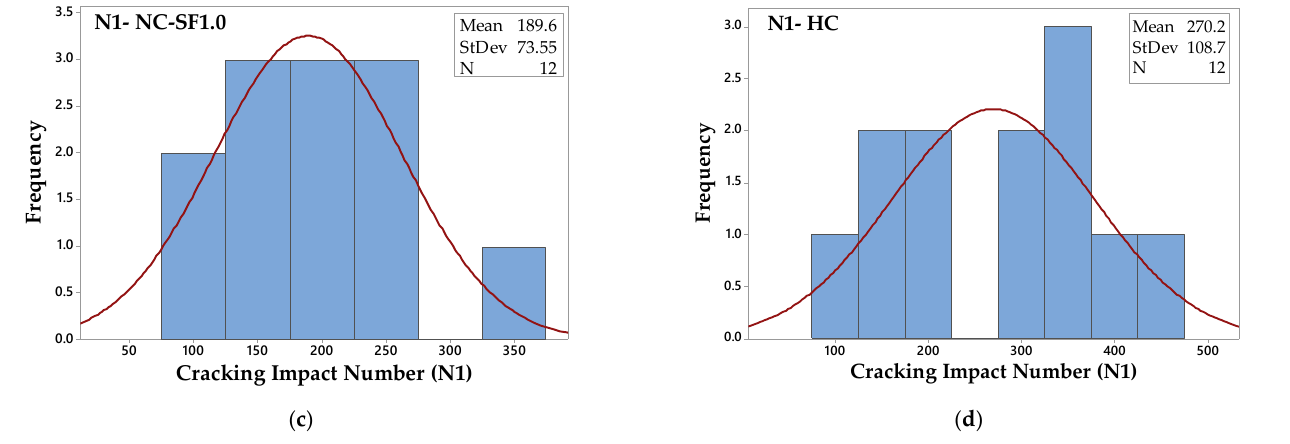
Figure 8. Distributions of results at the cracking stage for mixtures ( a ) NC ( b ) NC-SF0.5 ( c ) NC-SF1.0 and ( d ) HC.